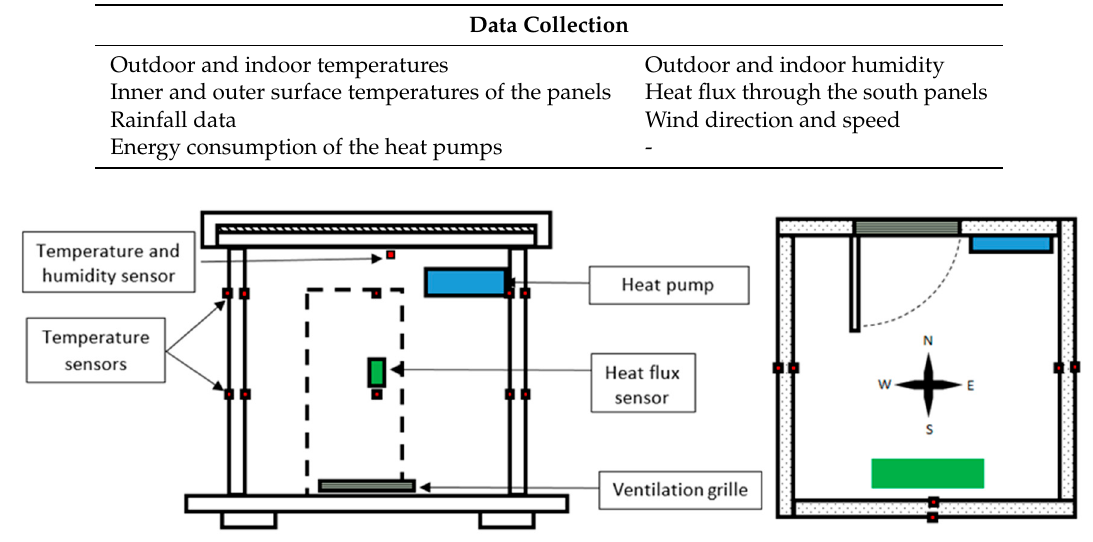
Figure 3. Orientation of cubicles and distribution of sensors and units.